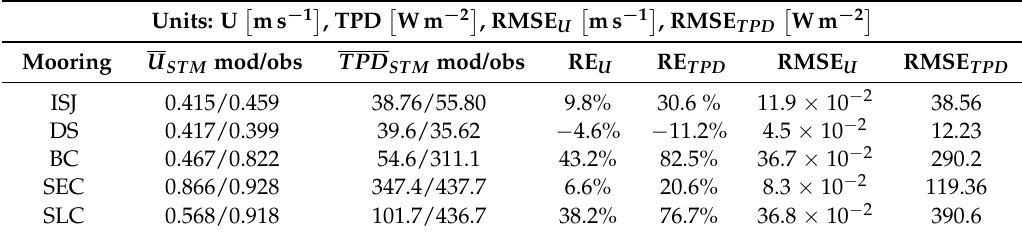
Table 2. Verification table for mean maximum spring tidal values.